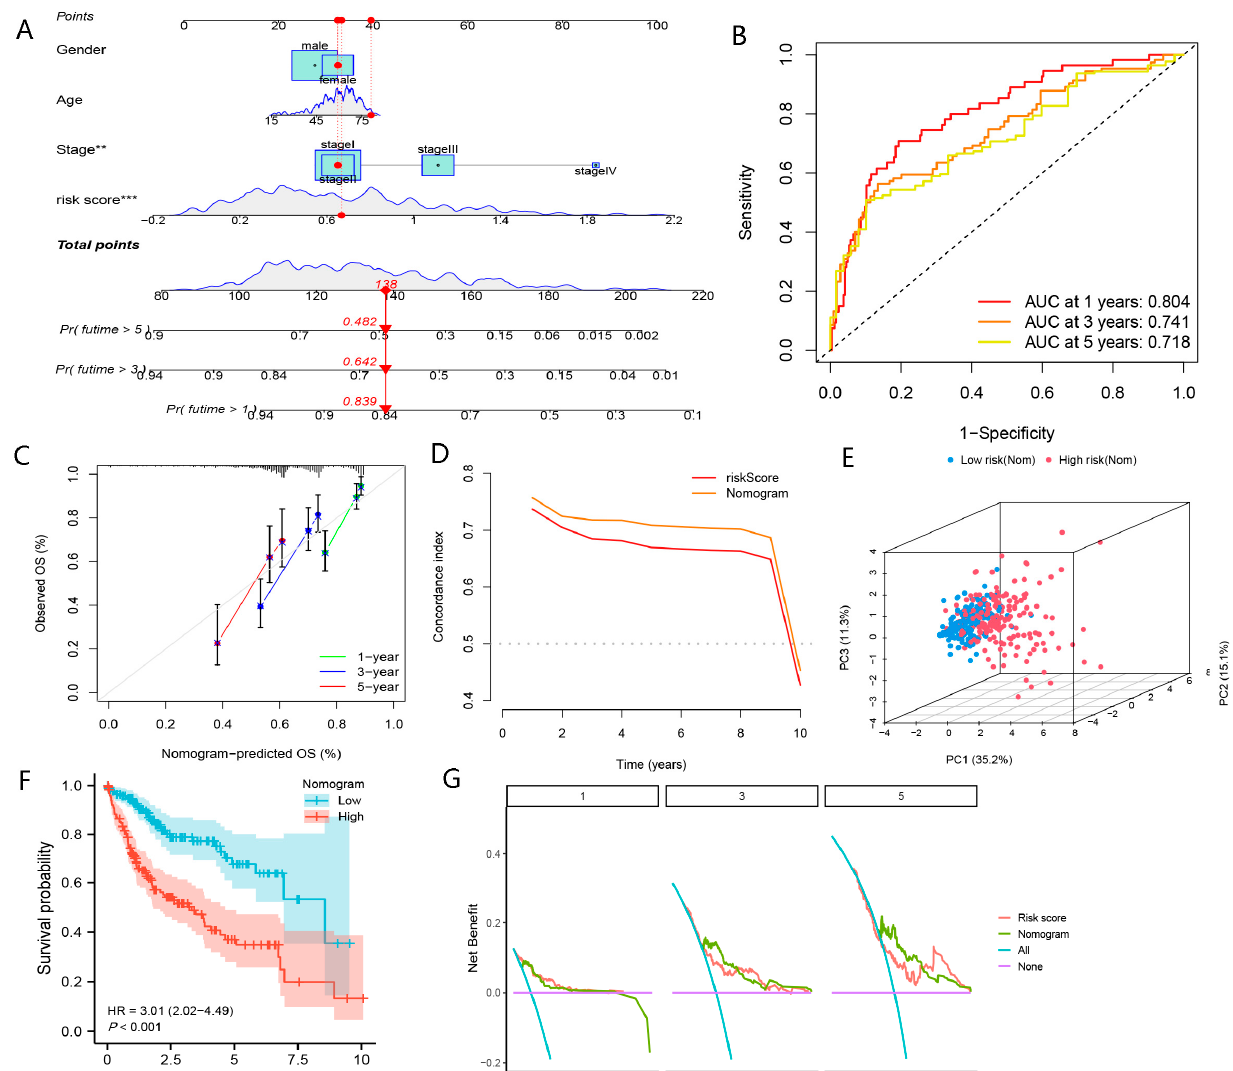
Figure 11. Construction of nomogram based on BMGs and other clinical features. ( A ) Construction of nomogram based on risk scores, TNM-stage, gender, and age. ( B ) The timeROC curve of nomogram. ( C ) The calibration curve of nomogram. ( D ) The c-index curve of nomogram. ( E ) PCA plot about nomogram. ( F ) KM curve of OS in high-risk (Nomogram) and low-risk (Nomogram) group. ( G ) DCA of nomogram for prediction of prognoses. (“**”, “***” represent p < 0.01, p < 0.001,